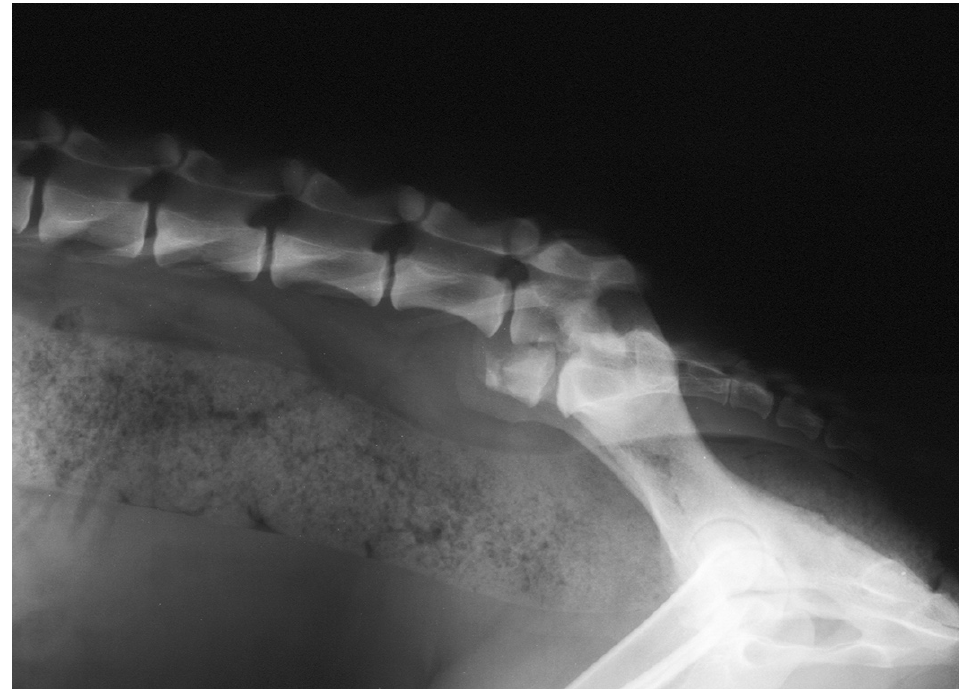
Figure 2. Post -t rauma lateral radiographic projection of the seventh lumbar vertebra fracture Figure 2. Post-trauma lateral radiographic projection of the seventh lumbar vertebra fracture showing cranio-ventral displacement of the showing cranio-ventral displacement of the sacrum.